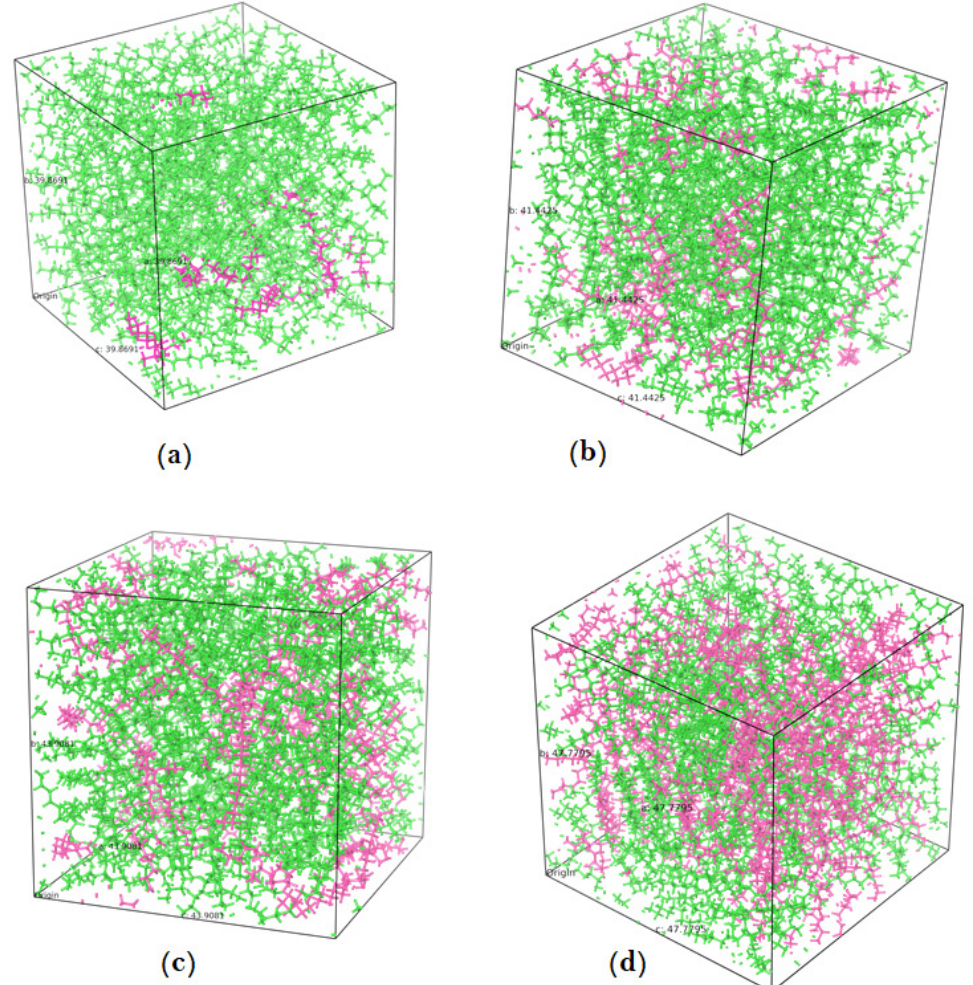
Figure 3. Equilibrated PE-wax system ( a ) 5.1 wt% wax ( b ) 17.1 wt% wax ( c ) 29.2 wt% wax and ( d ) 45.2 wt% wax (PE chains are green, wax molecules are pink).